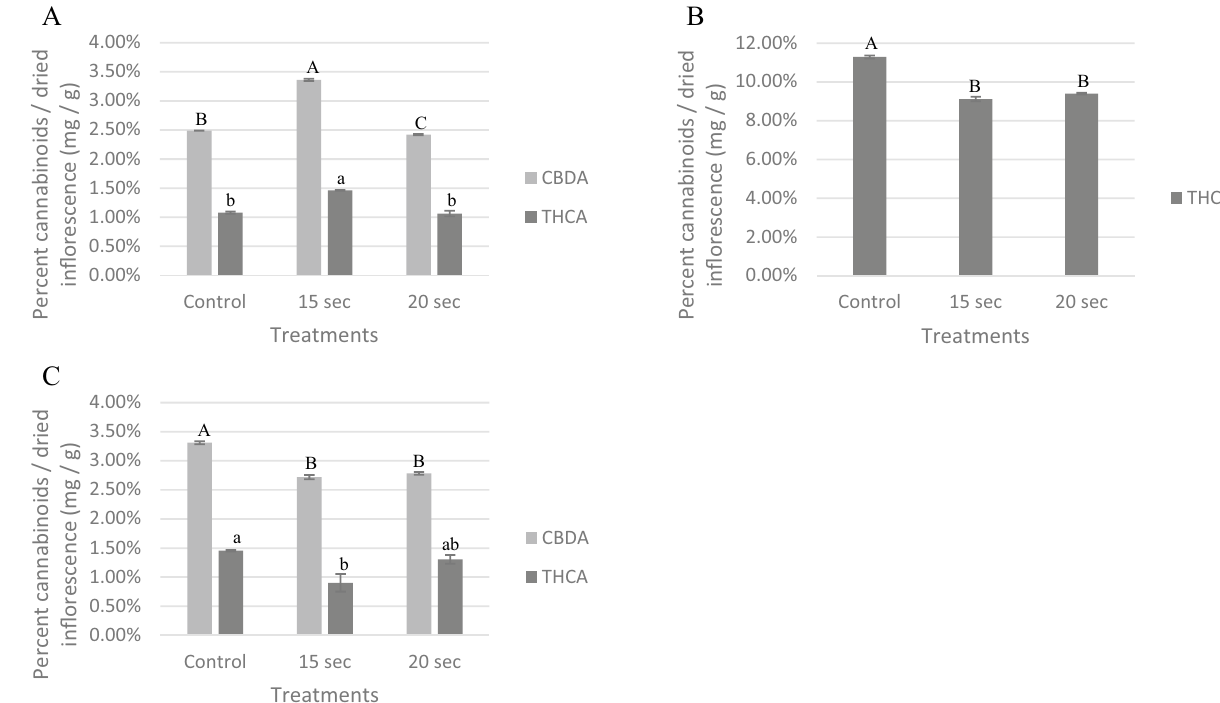
Figure 2. Percentage of different cannabinoids from commercial inflorescences calculated as relative cannabinoid dry weight per inflorescence for three separate experiments; A, B, and C. In each experiment, inflorescences were exposed to a steam treatment of 15 s at 65 °C and 20 s at 70 °C, and compared to an untreated control. The first ( A ) and third ( C ) experiments were conducted using inflorescences from the same commercial farm while the second experiment was conducted on inflorescences from a different farm. Cannabinoids that were present in low concentrations (> 0.5%) in the untreated control are not shown. Values compared for each cannabinoid between treatments, with a different letter are significant, according to Tukey HSD (α =